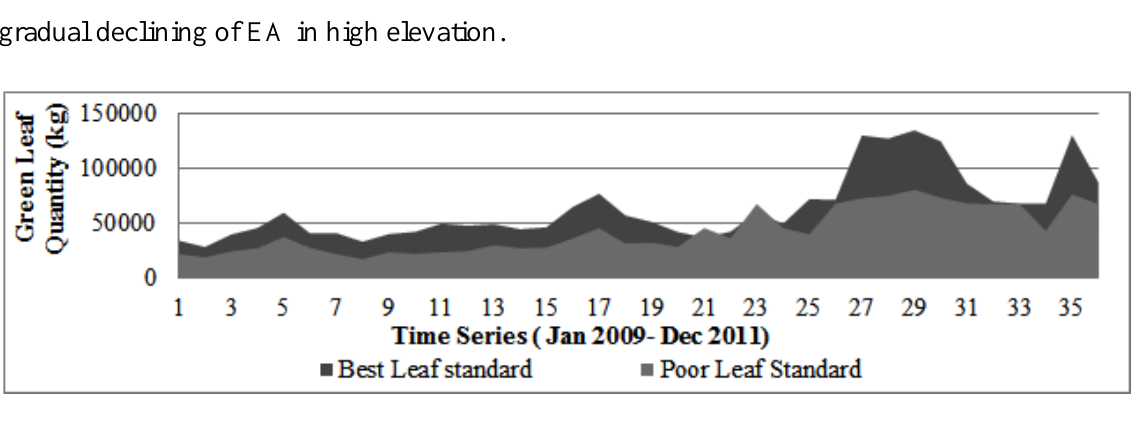
Fig 7: Fluctuations in Green Leaf Quantity of Best and Poor Leaf Standards over Three